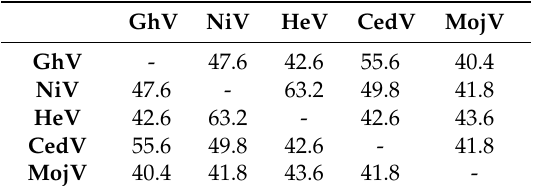
Table 1. Amino acid identity of the cytoplasmic domain (CD) of henipavirus G proteins. GhV NiV HeV CedV MojV GhV - 47.6 42.6 55.6 40.4 NiV 47.6 - 63.2 49.8 41.8 HeV 42.6 63.2 CedV MojV 40.4 41.8 43.6 41.8 -